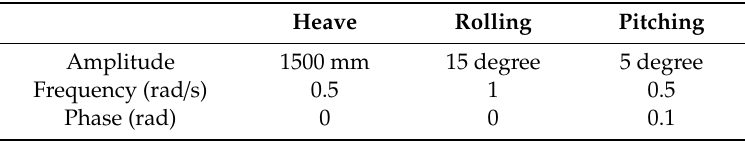
Table 1. Vessel motion simulating configuration